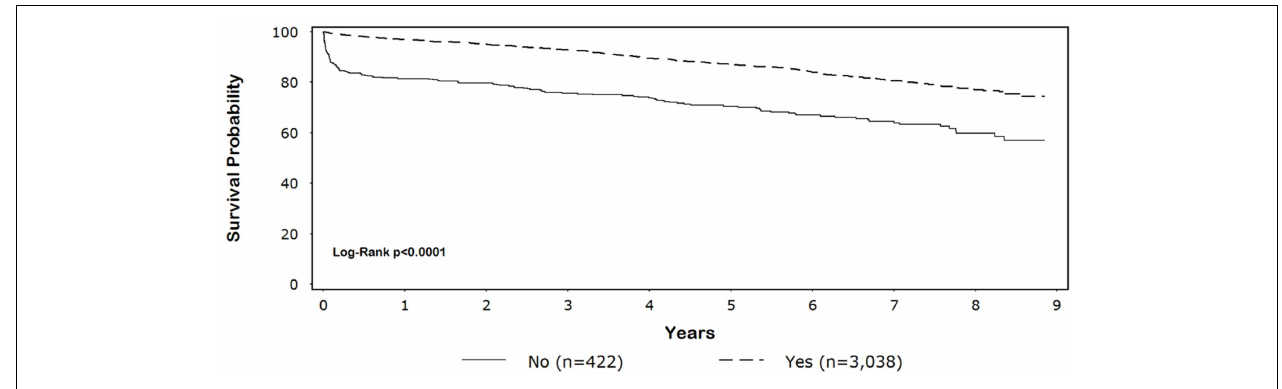
FIGURE 2 | Unadjusted Kaplan–Meier survival among white patients by β -blocker discharge status